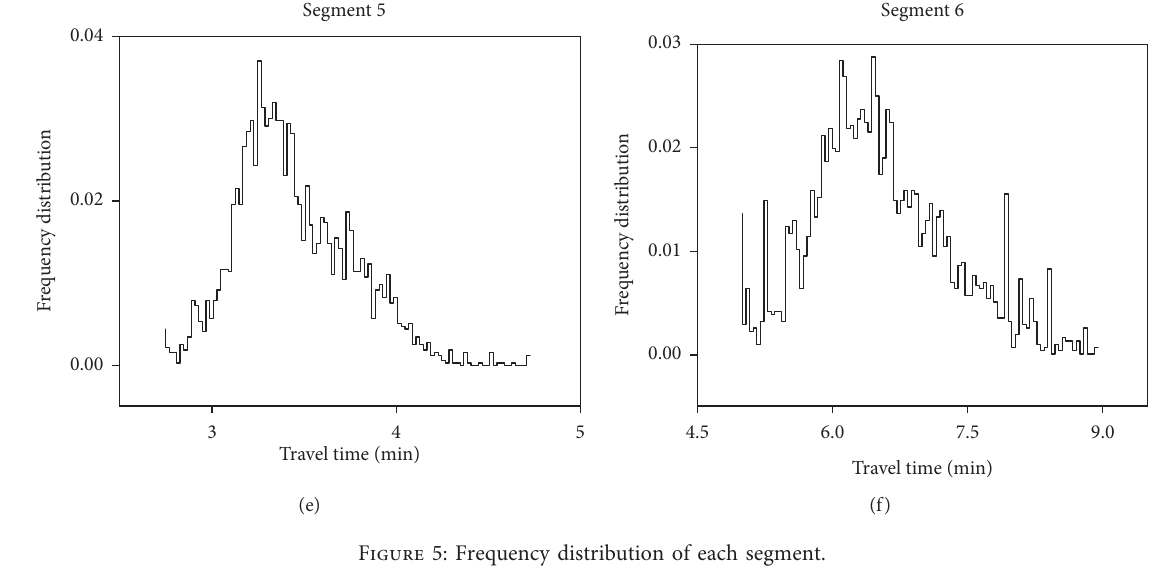
Figure 5: Frequency distribution of each segment.